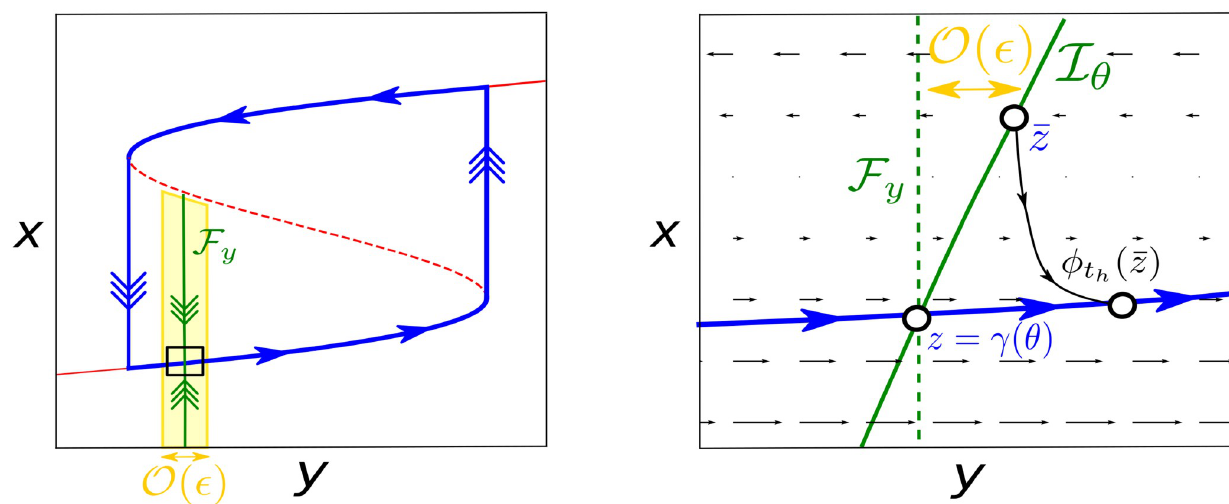
Fig 4. The slow vector field shapes the isochrons for relaxation oscillators. In the limit � ! 0 isochrons are lines of y constant denoted by F . However, y since � 6¼ 0 but small, the isochrons are O ð � Þ perturbations of F . As we show in the right panel, the sign of the O ð � Þ corrections depends on the difference y of speeds between the converging point � z and the base point z during the convergence time t . In this case, to approach Γ � , � z has to cross layers of x whose h values are smaller than the ones surrounding Γ � . For this reason � z travels slower than z . Since � z and z have to meet after a time t h at the same point on Γ � , but � z travels slower than z , then � z needs to travel a short distance. This determines the sign of the O ð � Þ correction. Furthermore, if the slow vector field is monotonous along the fast direction, the farther the point � z , the slower (faster) it travels, so the slope of the isochrons will have the same sign for all the points � z 2 I satisfying fast convergence, thus determining the effect of perturbations in the fast direction. y